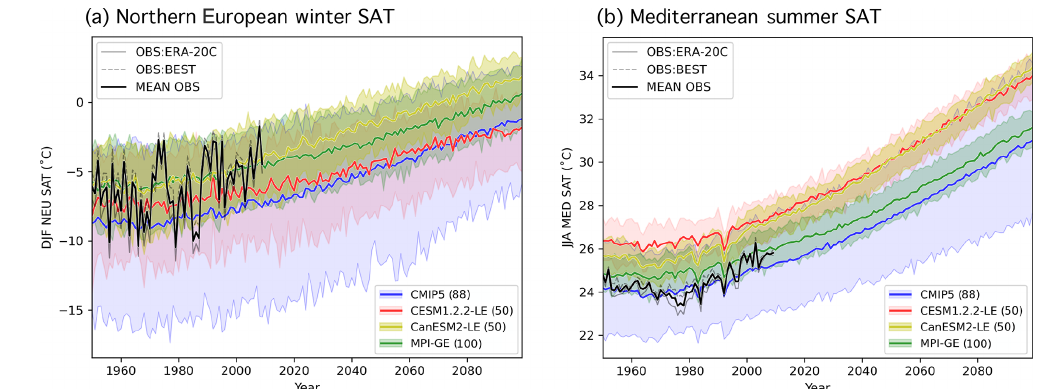
Figure 1. Observational estimates (OBS; gray), the CMIP5 ensemble (blue), and the three SMILEs CESM1.2.2-LE (red), CanESM2-LE (yellow), and MPI-GE (green) evaluated in this study, shown in terms of area-averaged and seasonally averaged absolute surface air temper- ature time series (SAT; ◦ C). The two OBS datasets, ERA-20C Temperature and the Berkeley Earth Surface Temperature (BEST) product, are shown in solid gray and dashed gray, respectively. Their average, used to determine member performance, is shown in solid black. For the CMIP5 and three SMILEs, the ensemble means across members are shown in solid color; the shading indicates the 5th–95th percentile of each distribution as a measure of ensemble spread. Note that the CMIP5 ensemble is a multi-model, multi-initial-condition member ensemble of 88 members from 40 (named) model setups, not the “one model, one vote” ensemble often used in multi-model ensemble studies. Panel (a) shows RCP8.5 projections for northern European winter (DJF NEU), and panel (b) shows RCP8.5 projections for Mediterranean summer (JJA MED) SAT. The number of members in each ensemble is indicated in parenthesis in the